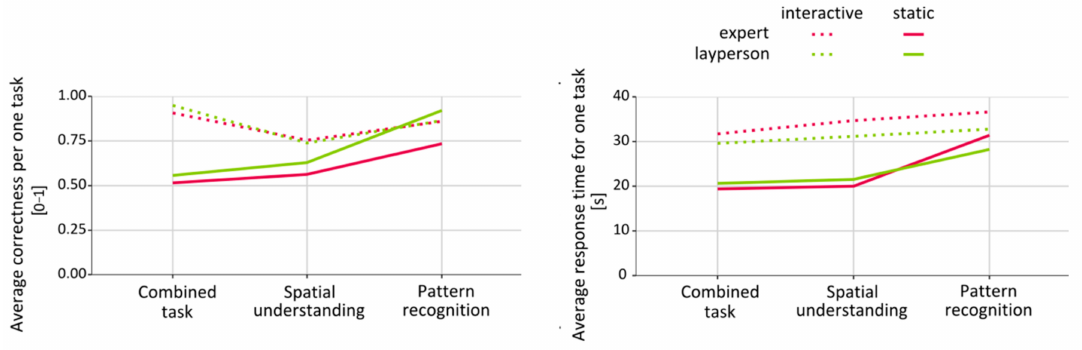
Figure 3. Average correctness ( left ) and average response times ( right ) by task type.